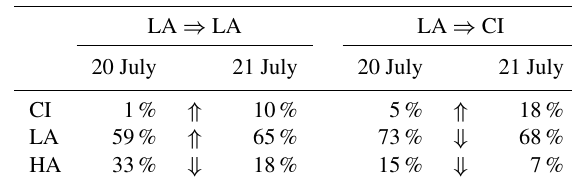
Table 1. Changes in the sub-S-2-pixel proportional coverage of the main surface classes from 20 to 21 July, aggregated for the S-2 pix- els which did not change class (LA ⇒ LA) compared to those which did (LA ⇒ CI). Vertical arrows show direction of change between